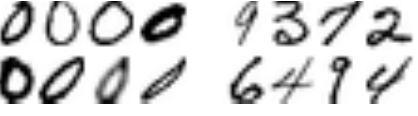
Fig. 3. 16 samples from the Cenparmi database, divided into classes (left) “zero” and (right) “not-zero”. Note that the machine learner does not have access to geometric adjacency information about the